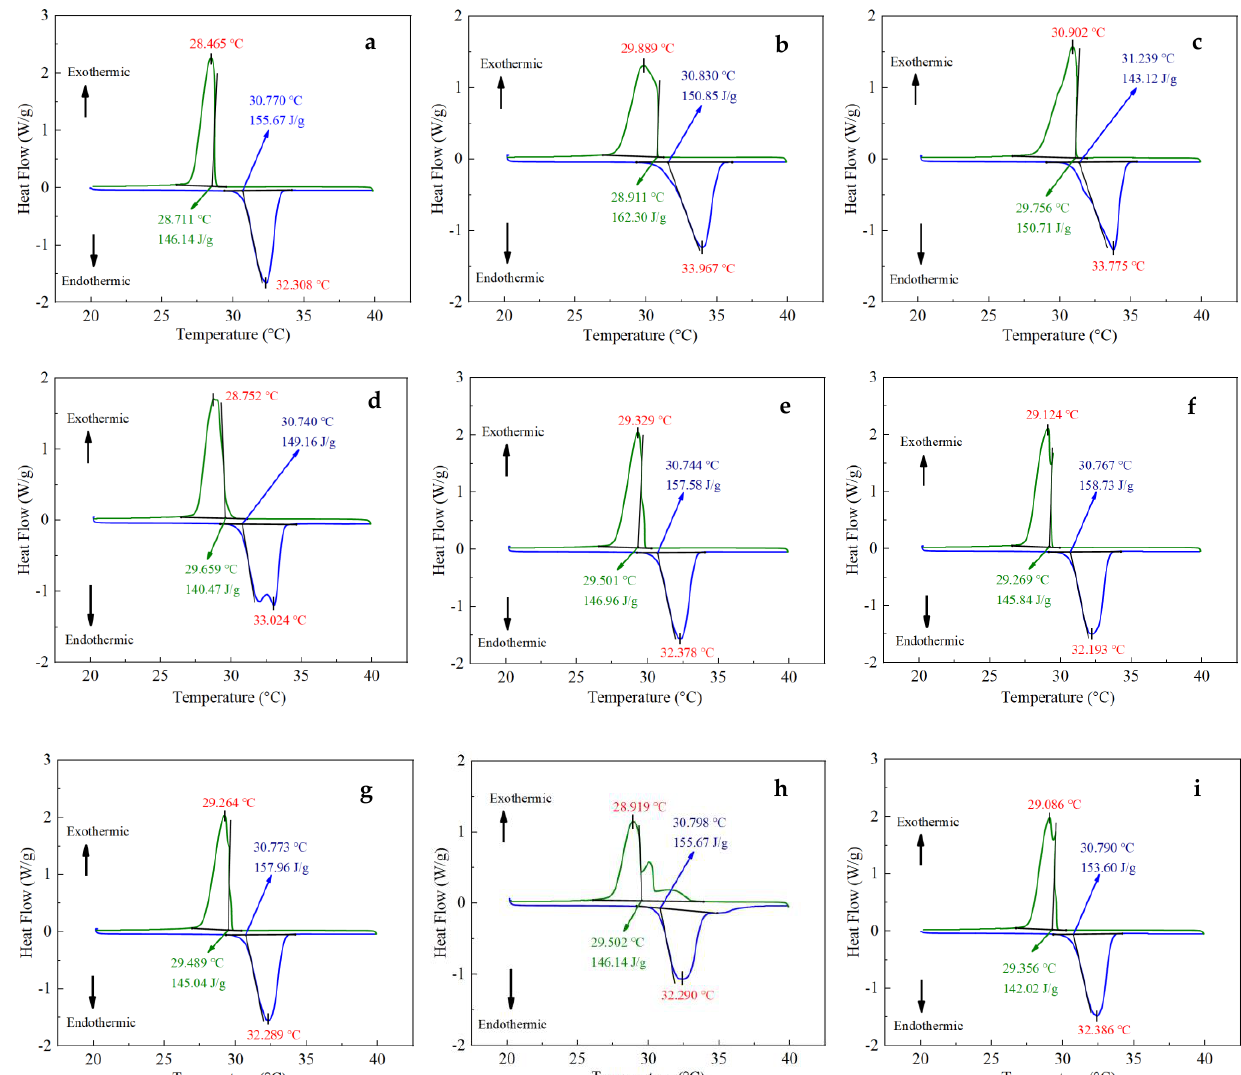
Figure 7. DSC curves of the composite PCMs: ( a ) 0 wt.% EG; ( b ) 1 wt.% EG; ( c ) 3 wt.% EG; ( d ) 5 wt.% EG; ( e ) 7 wt.% EG; ( f ) 9 wt.% EG; ( g ) 11 wt.% EG; ( h ) 13 wt.% EG; ( i ) 15 wt.% EG.